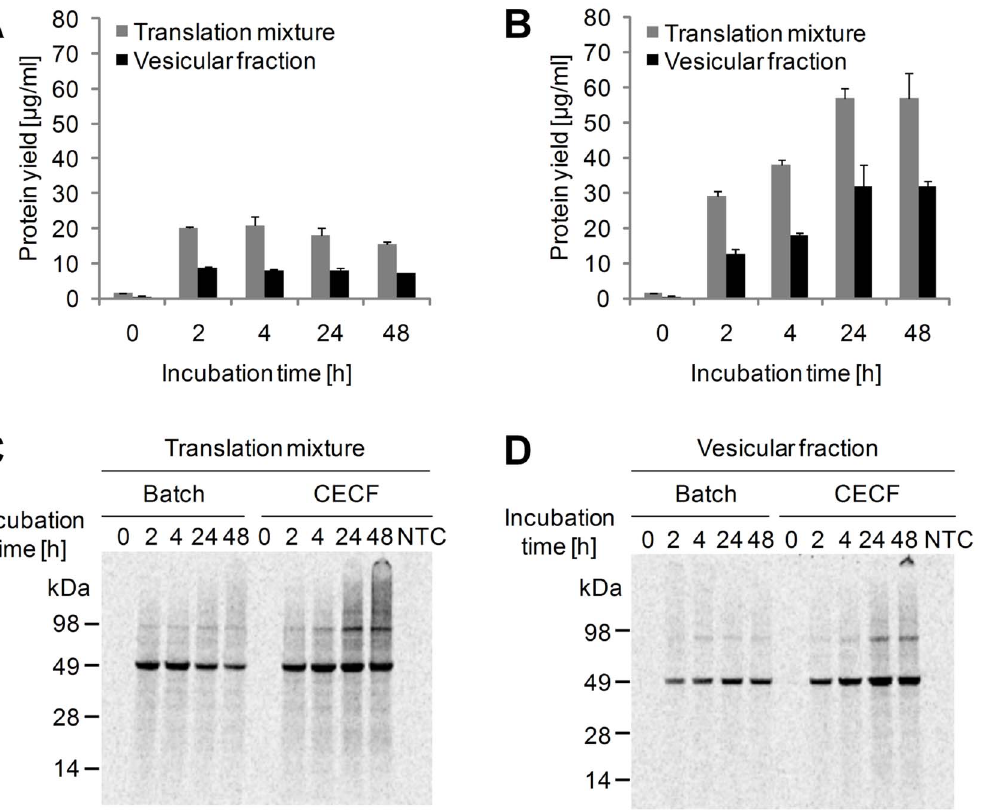
Figure 4. Time course analysis of the cell-free synthesized type-I transmembrane protein Mel-Hb-EGF-eYFP. Batch and CECF reactions were carried out in the presence of caspase inhibitor and 14 C-leucine and in the absence of DTT. Protein yields in batch (A) and CECF reactions (B) were determined in the translation mixture and the vesicular fraction by liquid scintillation counting. Standard deviations were calculated from triplicate analysis (n=3). C) Qualitative analysis of Mel-Hb-EGF-eYFP in the translation mixture by SDS-PAGE and autoradiography. D) Analysis of Mel- Hb-EGF-eYFP in the vesicular fraction. Cell-free synthesized Mel-Hb-EGF-eYFP shows a migration pattern corresponding to its expected molecular mass (calculated molecular mass =51 kDa). NTC = No template control; translation reaction without addition of a DNA template.